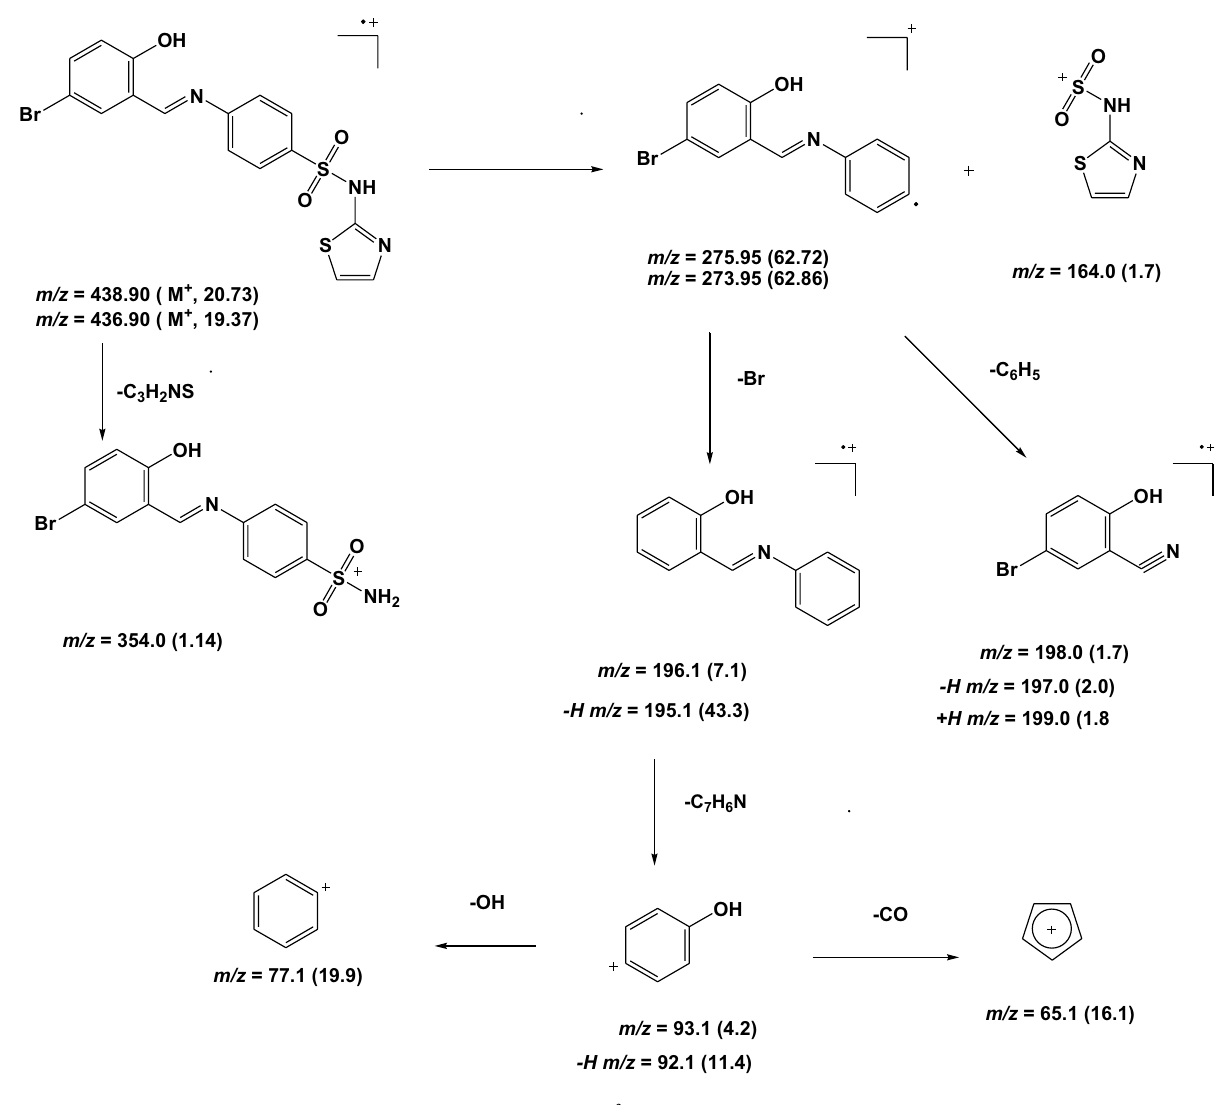
Figure 7. Proposed mass fragmentation SB 2